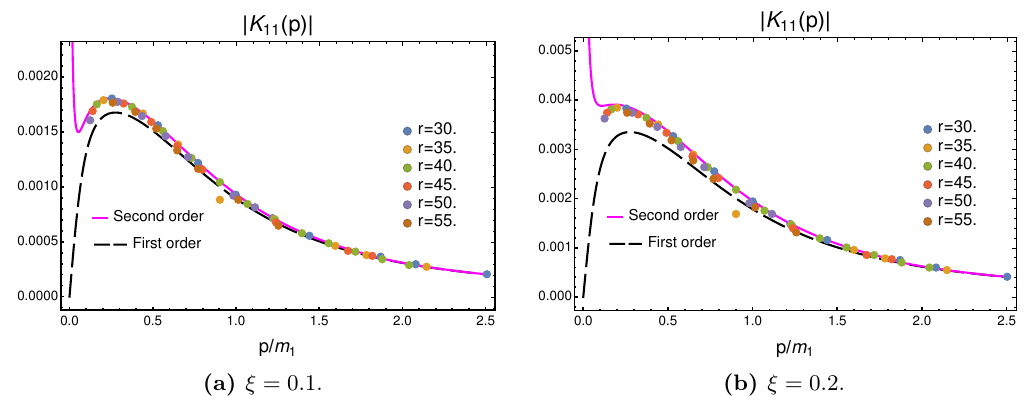
Figure 3 . Numerical and analytical two-particle overlaps after quenches of size (a) ξ = 0 . 1 and (b) ξ = 0 . 2 along the E 8 axis. The overlap was determined by TCSA using volumes in the range m 1 R = 30 . . . 55 . Conventions are as in figure 2. While at high energies TCSA results are predicted correctly, the low-energy points tend to deviate further from the perturbative prediction upon increasing the quench amplitude.